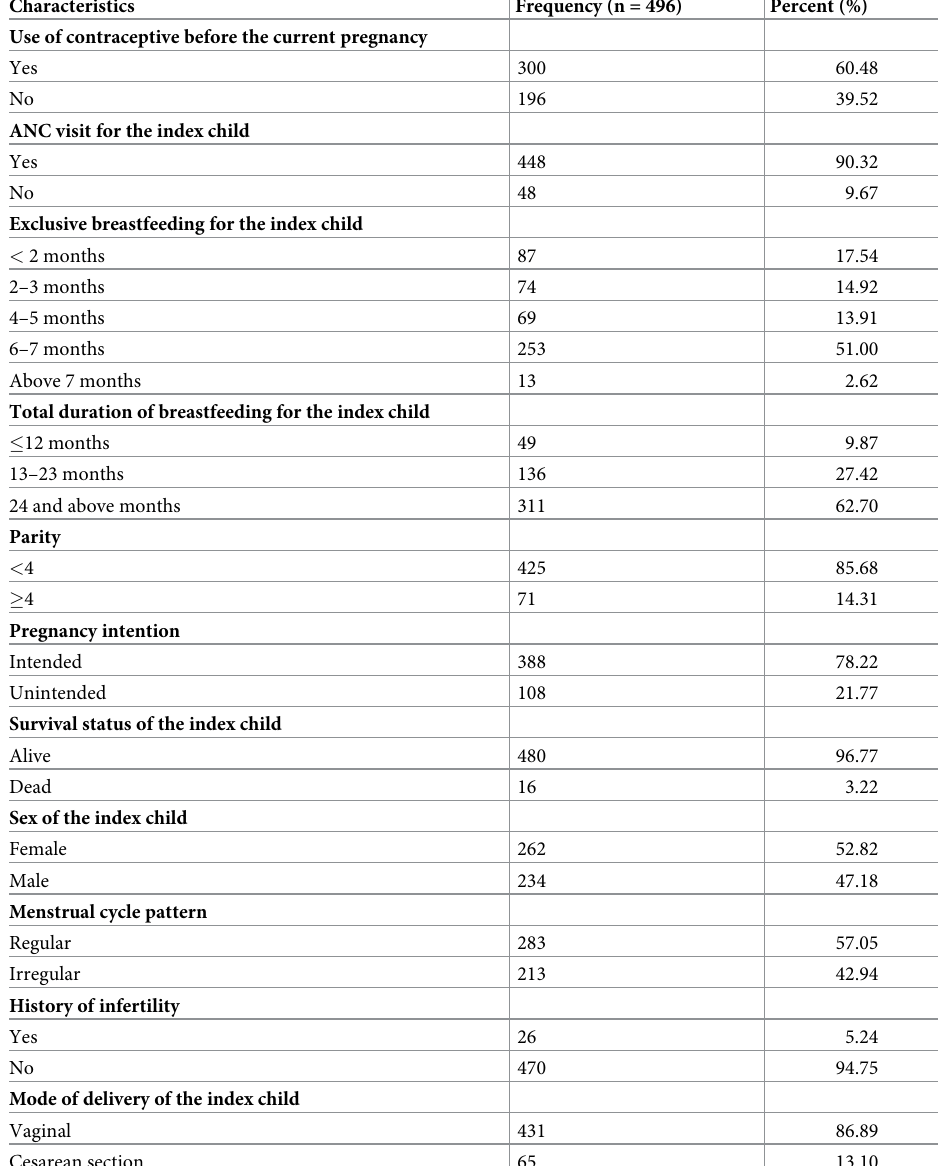
Table 2. Reproductive and health service related factors of pregnant women in Debre Berhan town, Amahra region, Ethiopia, 2020.